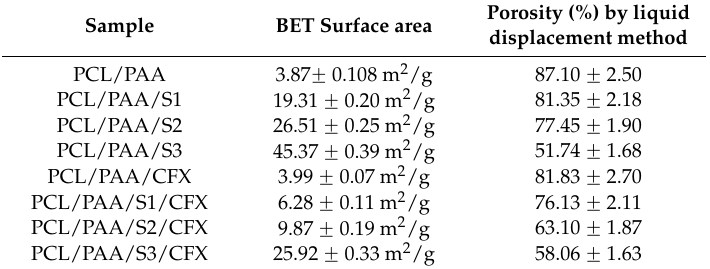
Table 2. BET surface area and porosity (%) results by liquid displacement of all scaffold blends.